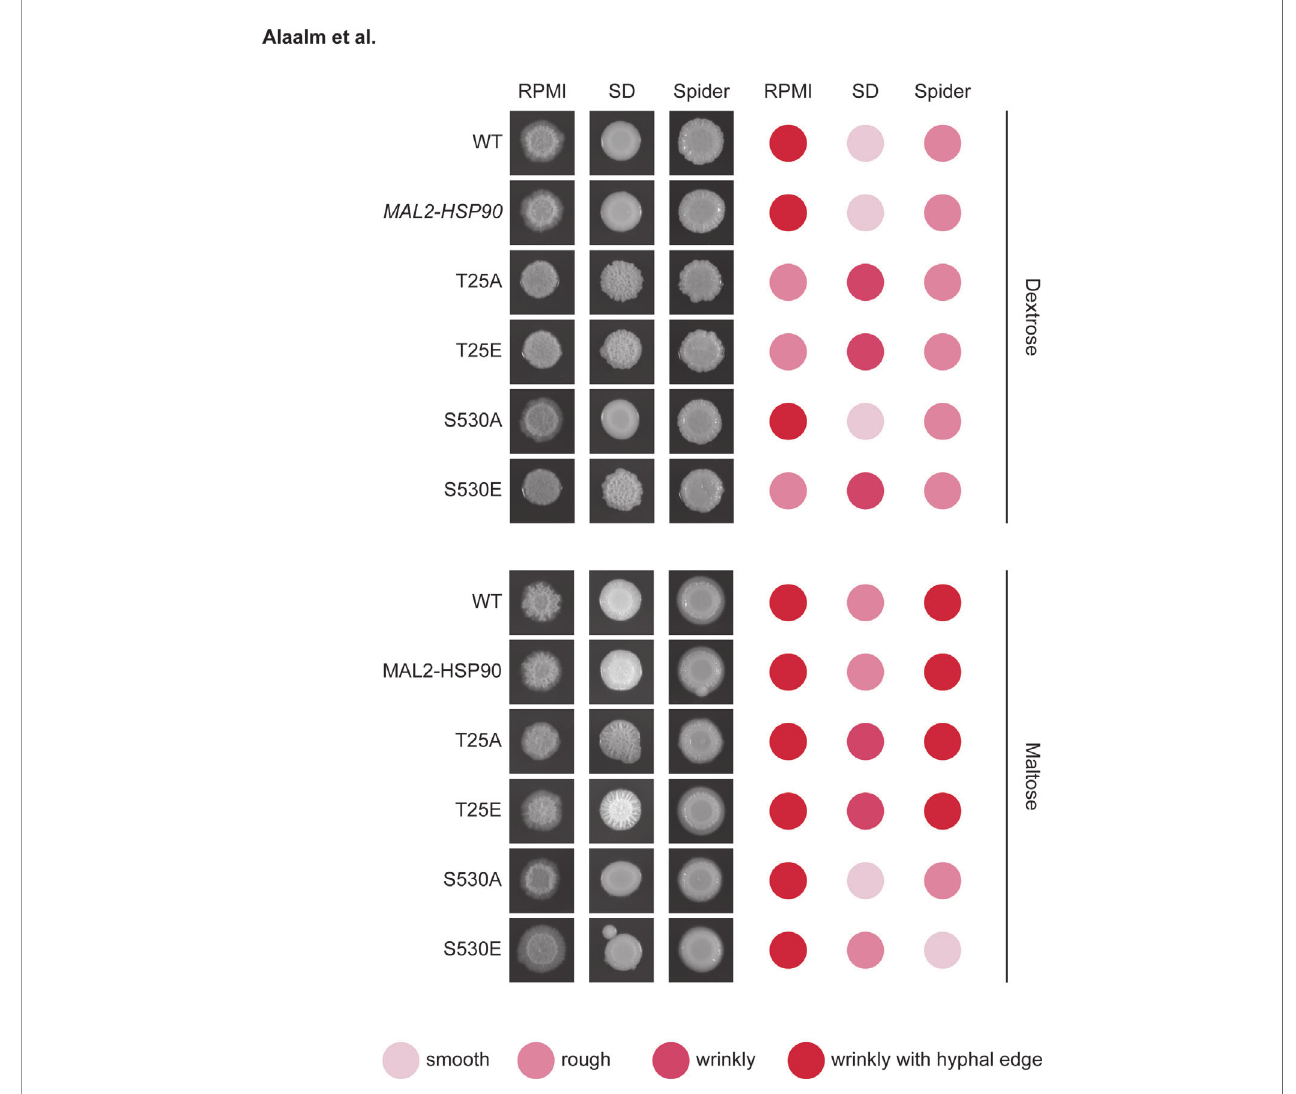
FIGURE 4 | Aberrant colony morphology in response to changes in Hsp90 phosphorylation patterns. Images of colonies spotted onto RPMI, Spider or synthetic de fi ned (SD) media containing either dextrose (top) or maltose (bottom). Colonies were scored for their appearance. The darker red the dot, the more extreme the colony phenotype. Shown is one of two